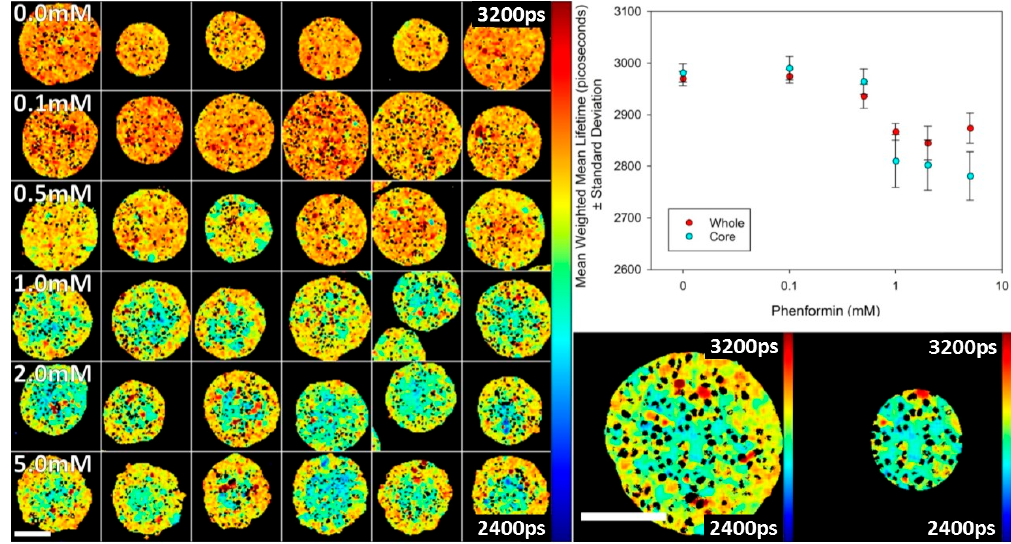
Figure 7. Titration of phenformin in spheroids expressing T2AMPKAR-NES using TPE TCSPC FLIM. Left Panel : montage of FLIM maps of the weighted mean fluorescence lifetimes as phenformin concentration is increased (shown in panel). Upper right panel : plot of the whole spheroid and core mean weighted mean lifetimes; Lower right panel : exemplar images of the whole spheroid and core region segment. Lifetimes are shown in picoseconds (shown in image). Scale bars = 100 µm.